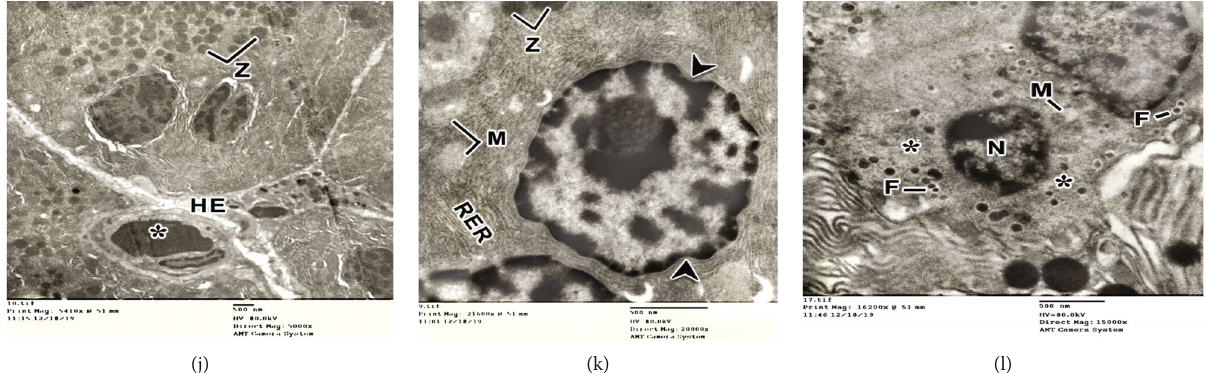
Figure 6: Electron micrographs of a pancreatic acinar cell of control developing rat demonstrating (a) zymogen (Z) granules, arrays of rough endoplasmic reticulum (RER), and mitochondria (M) with basally located nucleus (N); (b) parts of β , α , and δ cells; (c) parts of two β cells with spherical-shaped nuclei (N). β granules (g) have dark central core surrounded by an electron lucent halo (arrows). Electron micrographs of pancreas acinar cells of diabetic developing rat showing (d) decrease of the zymogen (Z) granules; (e) shrinkage and pyknotic nucleus (N), vacuolized mitochondria (M), and extensive fragmented arrays of rough endoplasmic reticulum (RER); (f) β cell in Langerhans islet of the pancreas displaying cytoplasmic vacuolation (V), obvious decrease of secretory granules (arrow), and pyknotic nucleus (N). Electron micrograph of pancreatic acinar cells of a diabetic developing rat treated with mesenchymal stem cells during early period (diabetic+MSCs1 group) illustrating (g) the acinar cells appeared nearly similar to the normal form with basally located normal nuclei (N) and normal aggregation of zymogen (Z) granules with few degenerated mitochondria (M) and arrays of rough endoplasmic reticulum (RER). (h) Aggregation of β cells which appeared nearly like the control group, euchromatic oval nucleus (N); few vacuoles in β cells and increase of the secretory granules (arrows) surrounded by electron lucent halo; (i) oval nucleus (N); increase in the secretory granules (arrows) with some vacuolized mitochondria (M). Few vacuoles are also seen (V). Electron micrographs of (j, k) pancreatic acinar cells and (l) β cell in Langerhans islet of a diabetic developing rat treated with mesenchymal stem cells in a late period (diabetic+MSCs2 group) showing (a) hemorrhage edema (HE) among the acini with congestion in the blood vessels ( ∗ ). (b) Damaged mitochondria (M); dilated rough endoplasmic reticulum (RER), zymogenic granules (Z), and an irregular nuclear envelope (arrowheads). (c) Vacuolized mitochondria (M) lost most their cristae and a scarcity of β granules in some β cells ( ∗ ). Fusion of some granules (F) is also seen. The nucleus (N) of islet β cell appeared with an irregular